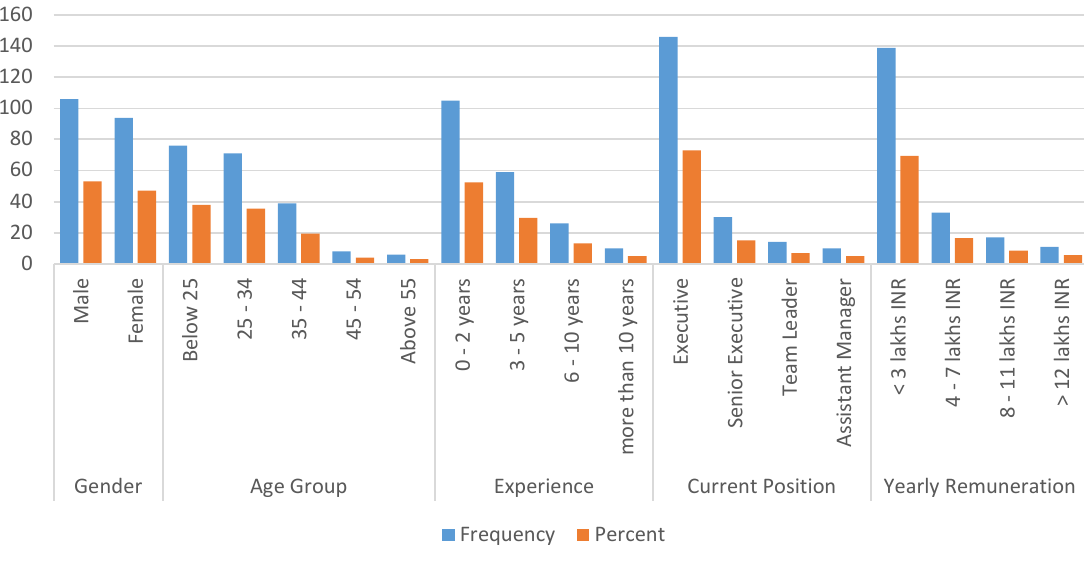
Figure 1. Descriptive analysis of the demographic background of respondents